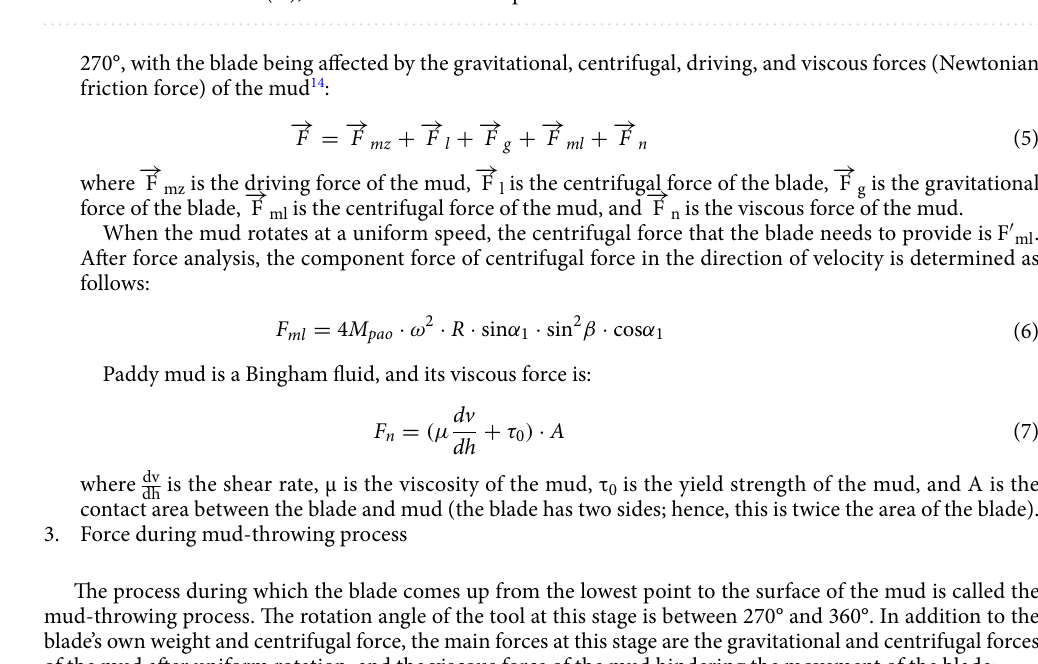
Figure 4. Operation process and force diagram of paddy field blade ( a ) operation process; ( b ) force analysis. ɑ 1 is the angle between the front cutting surface and the velocity direction (°), β is the bending angle of the tangent plane (°), F ′ ml is the centrifugal force of the mud (N), F’g is the gravitational force of the mud (N), Fn is the viscous force of the mud (N), and Ve is the absolute speed direction of the